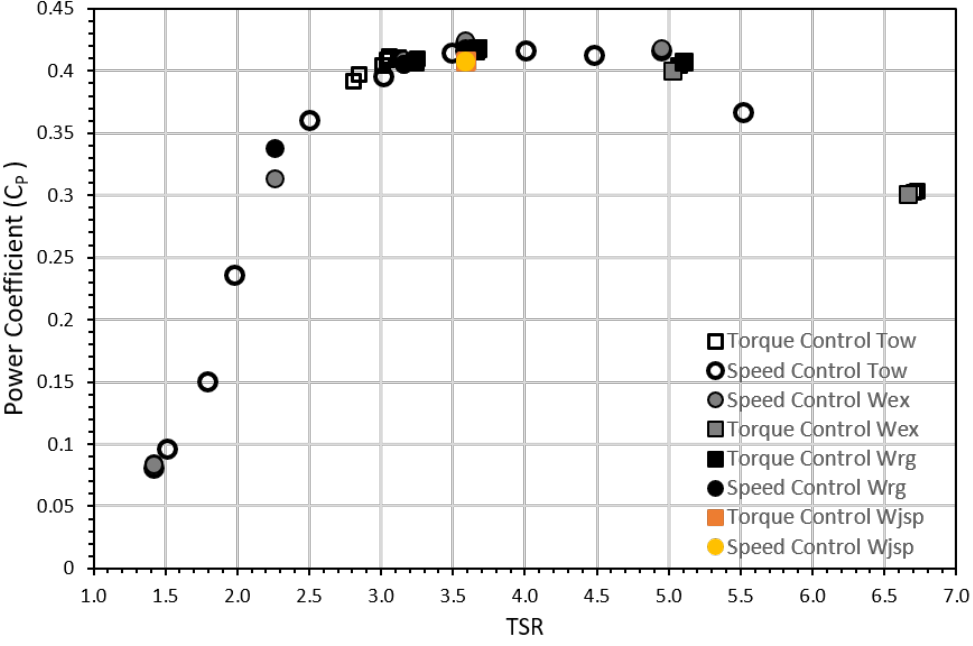
Figure 6. Power Coefficient ( C P )—Tip speed ratio (TSR) curve including all the test cases for both control strategies.